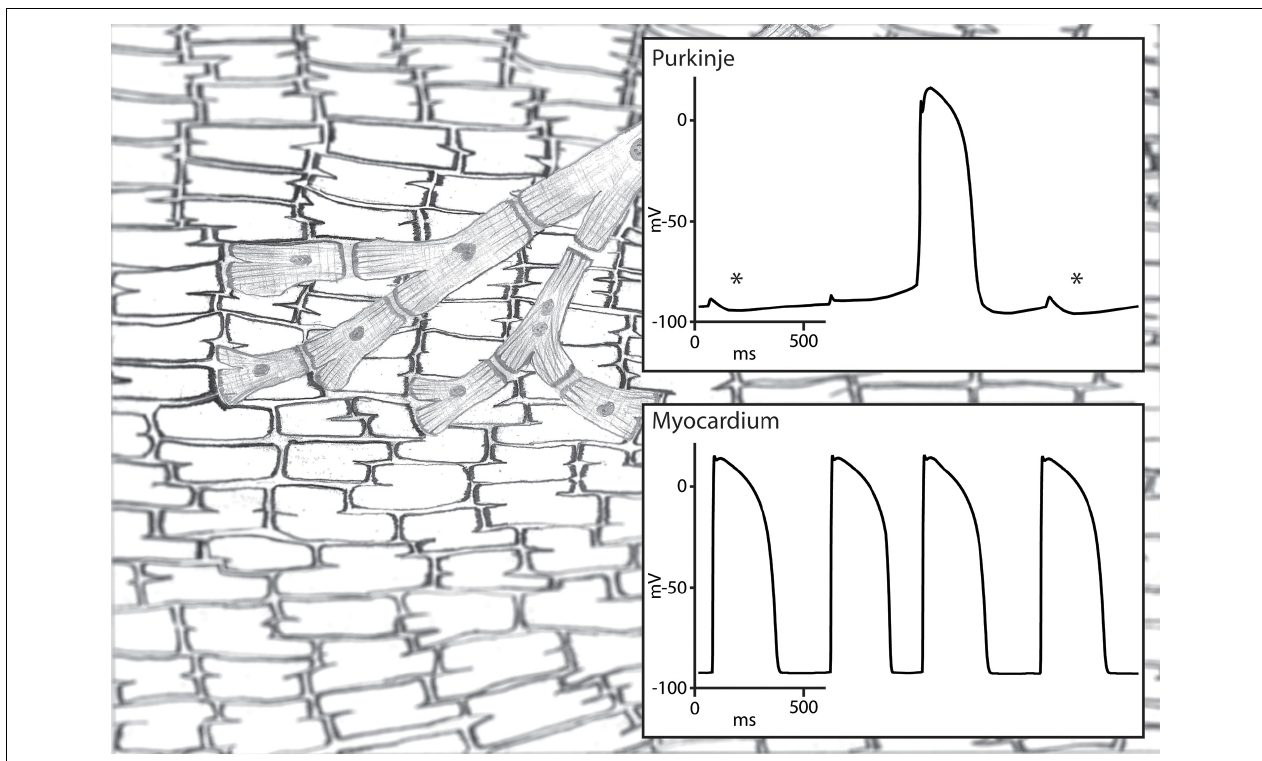
FIGURE 2 | Illustration of modulated parasystole. A Purkinje fiber and ventricular myocardium are shown on the left and their transmembrane potentials on the right. The Purkinje fiber is protected from reset by the ventricular activation due to functional conduction block and is activated by its intrinsic automaticity. This automatic rhythm in the Purkinje fiber is influenced by the subthreshold depolarization by the surrounding myocardium. Subthreshold depolarization during the early phase 4 depolarization is followed by hyperpolarization (highlighted by an asterisk) which delays phase 4 depolarization reaching threshold potential. Subthreshold depolarization during later stage of phase 4 depolarization is not followed by hyperpolarization and advances the next automatic activation. The automatic activation of the Purkinje fiber activates the myocardium because the functional conduction block is